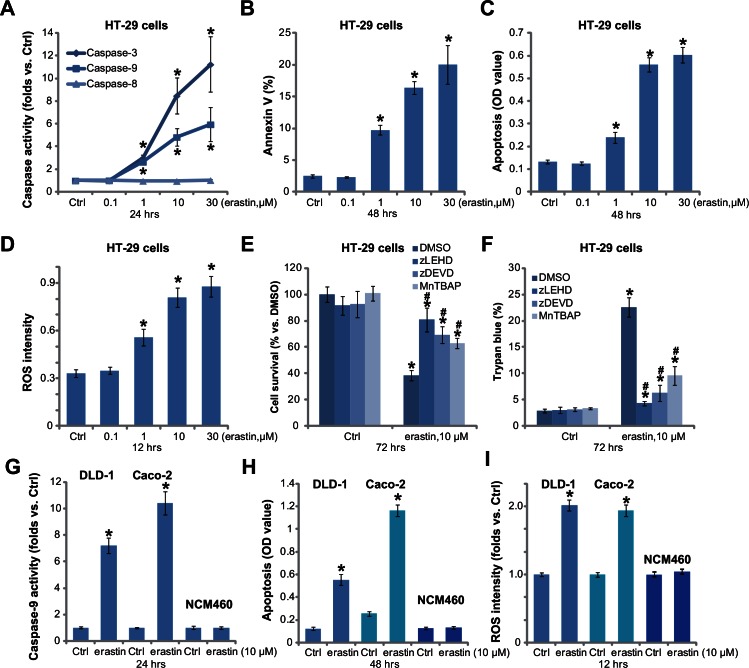
Erastin induces ROS production and caspase-dependent apoptosis in cultured colorectal cancer cells.Colorectal cancer cells (HT-29, DLD-1 and Caco-2 lines) or NCM460 colon epithelial cells were treated with vehicle control (0.1% DMSO, “Ctrl”) or indicated concentrations of erastin for applied time, cell apoptosis was examined by listed assays (A-C, G and H); ROS production was also examined (D and I). HT-29 cells were pre-treated with z-DEVD-fmk (“zDEVD”, 50 μM), z-LEHD-fmk (“zLEHD”, 50 μM) or MnTBAP (10 μM) for 1 hour prior to applied erastin stimulation, cell survival and cell death were tested by MTT assay (E) and trypan blue assay (F), respectively. For each assay, n = 5. The data presented were mean ± SD. Experiments were repeated three times with similar results obtained. * p < 0.05 vs. group of “Ctrl”. # p < 0.05 vs. group of erastin only (E and F).